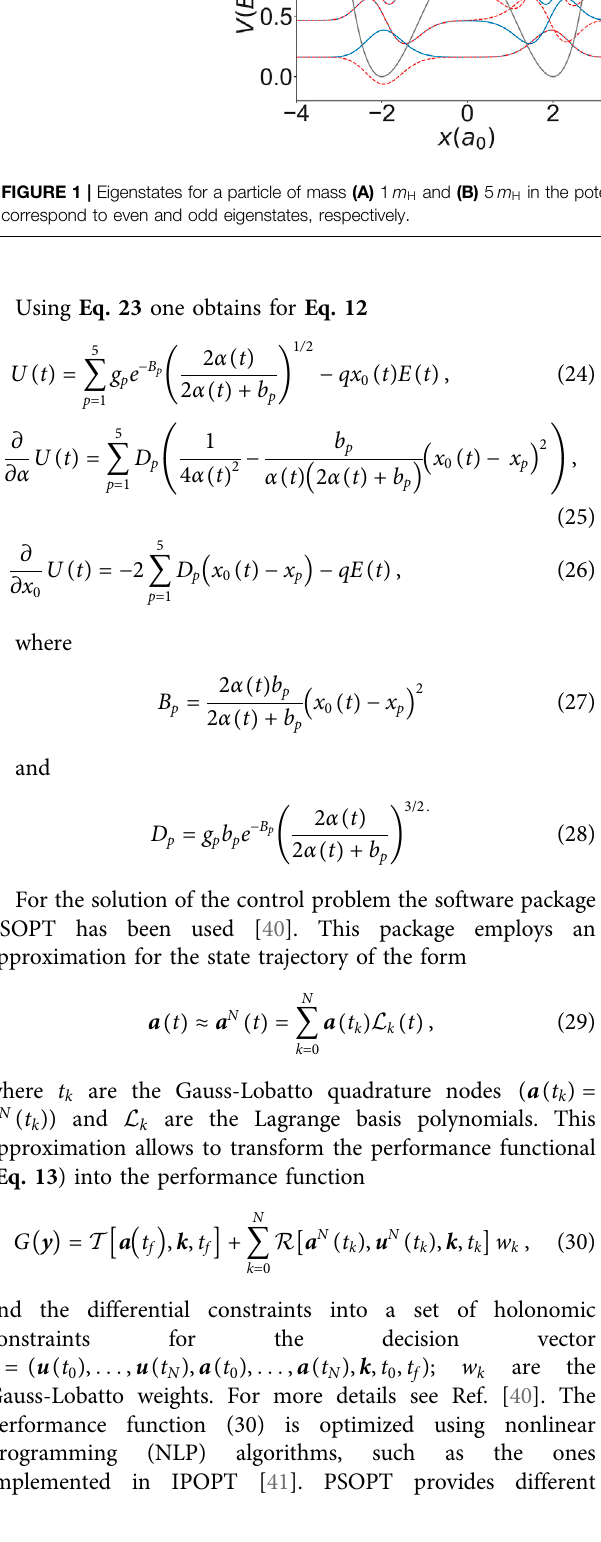
Frontiers in Physics |